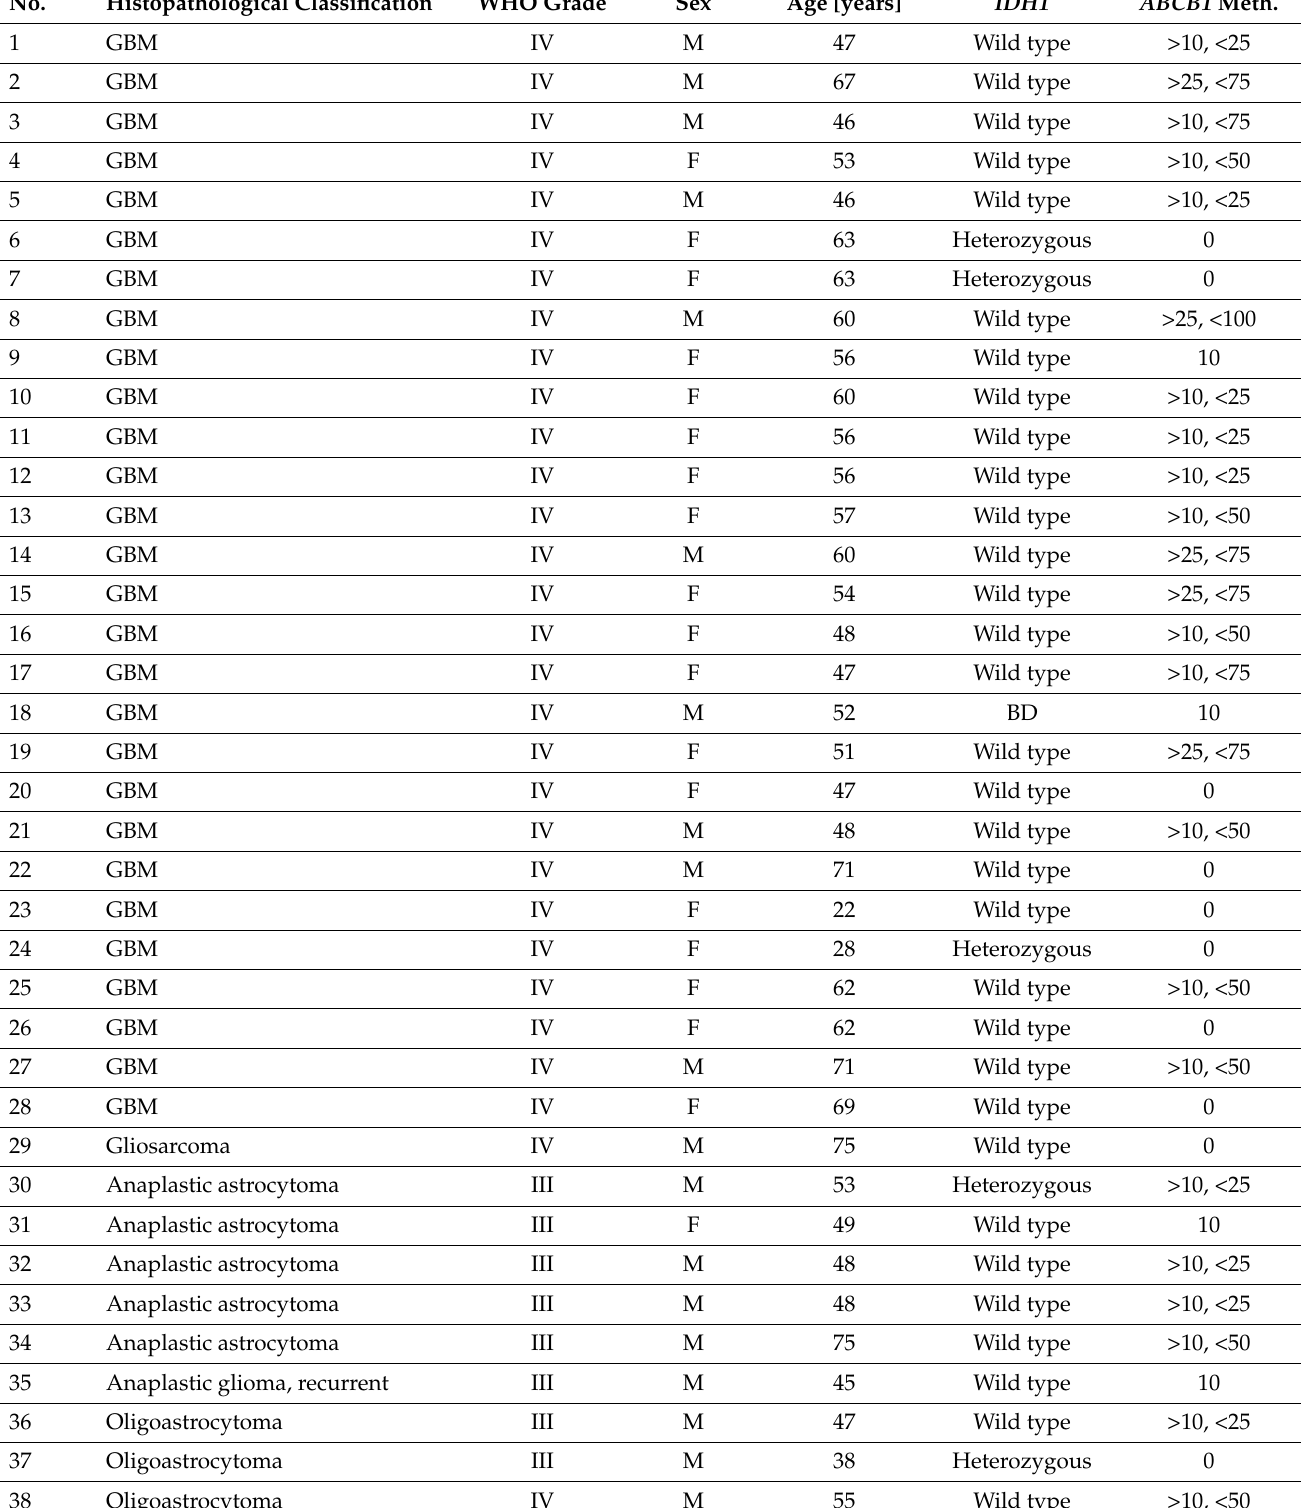
Table 2. Patients’ characteristics and the results from IDH1 mutation and ABCB1 methylation